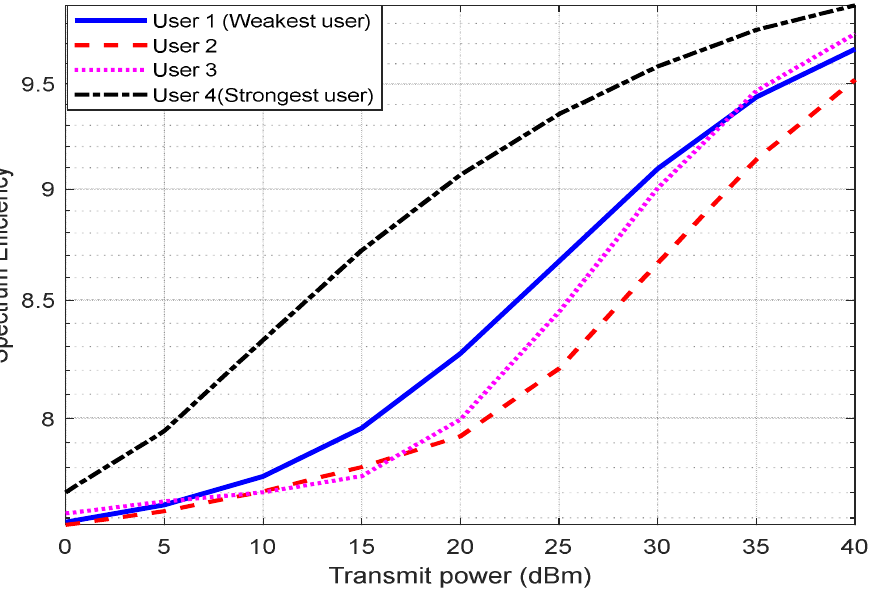
Figure 8. SE against transmitting power for four users with varying distances, with power coefficients and BW 200 MHz for DL NOMA.